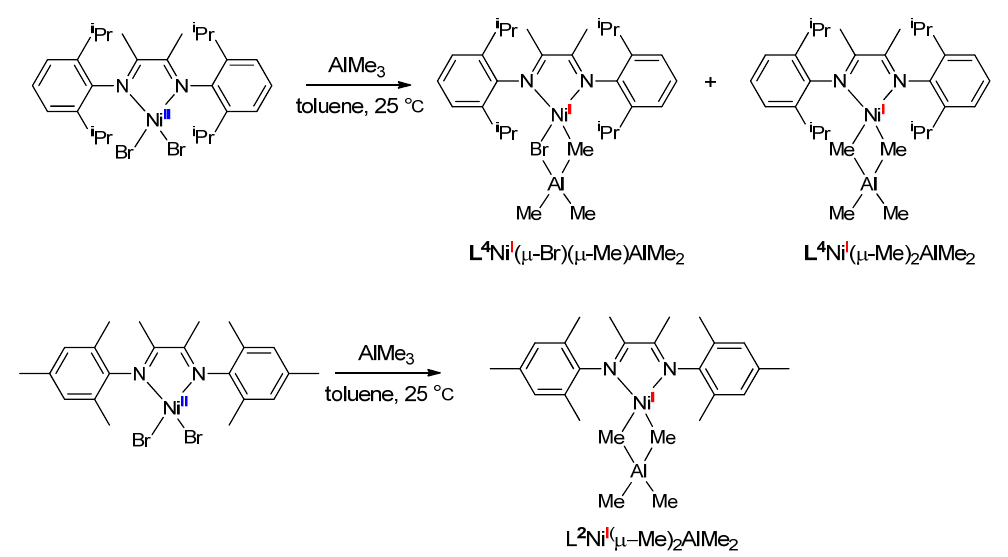
Scheme 5. Structures of complexes L 4 Ni I ( μ -Br)( μ -Me)AlMe 2 and L 4 Ni I ( μ -Me) 2 AlMe 2 formed in the